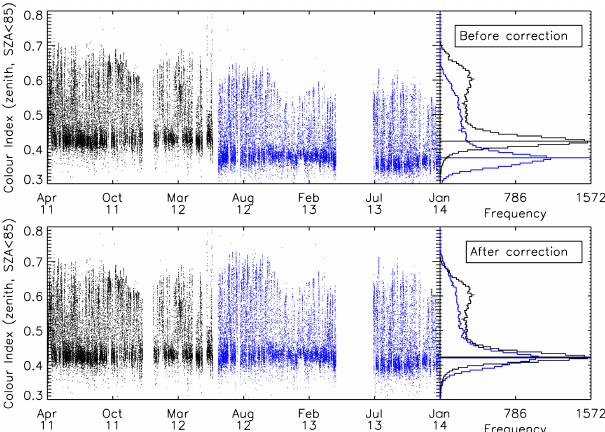
Figure 5. Illustration of the CI correction for Brussels due to an instrumental failure on May 20th 2012. The top panel shows the CI values and histograms before and after the incident in black and blue respectively. The bottom panel shows the corrected CI values. This was done by shifting the blue points in such a way that both histograms have the same peak